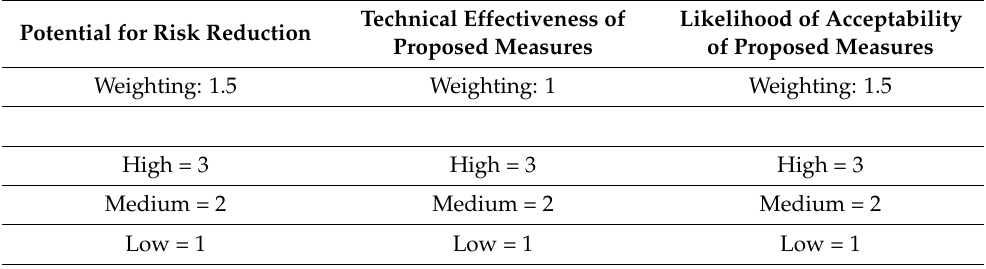
Table 4. A ranking chart for comparing possible risk reduction measures from three different perspectives ([16], modified). Technical Effectiveness of Likelihood of Acceptability Potential for Risk Reduction Proposed Measures of Proposed Measures Weighting: 1.5 Weighting: 1 Weighting: 1.5 High = 3 High = 3 High = 3 Medium = 2 Medium = 2 Medium = 2 Low = 1 Low = 1 Low = 1 Priority score = (potential × its weighting) × (effectiveness × its weighting) × (acceptability ×